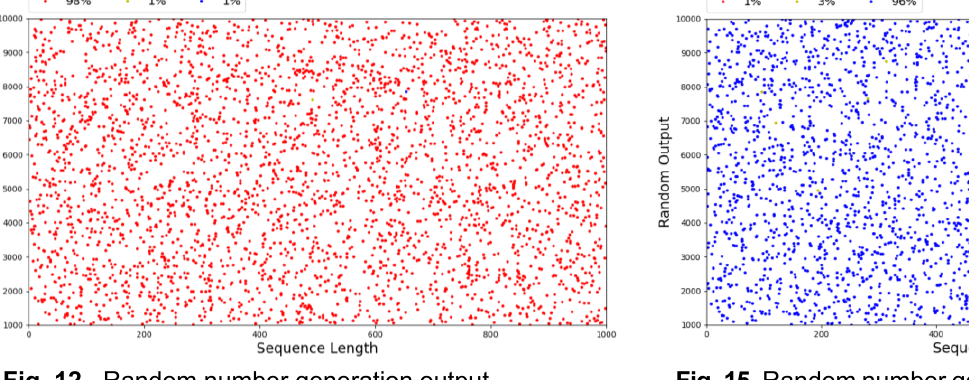
Fig. 12. Random number generation output frequency scatter plot without audio seed